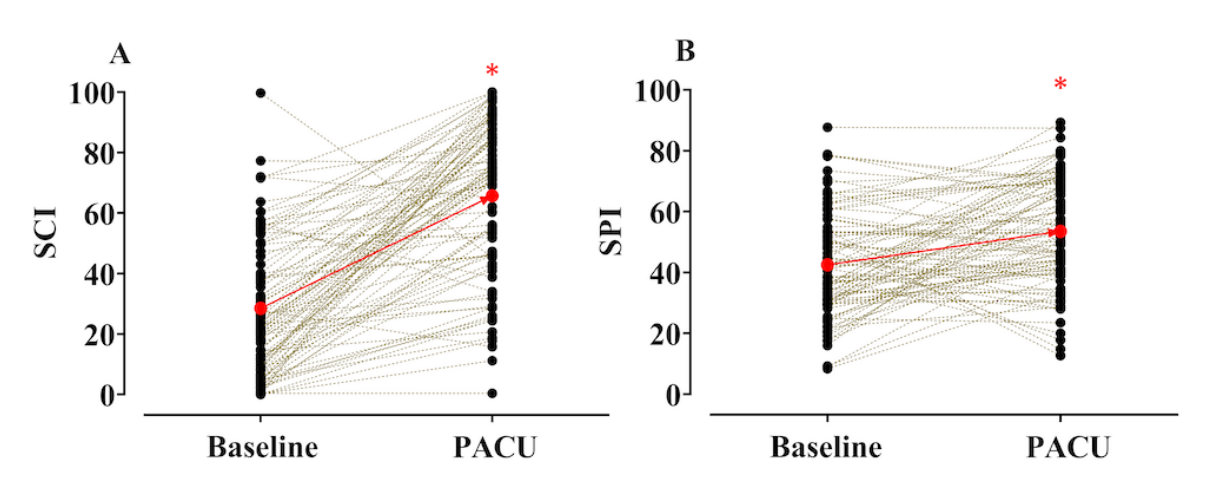
Figure 3. Individual changes (n=100) in the spectrogram-convolutional neural network index (SCI, A) and the Surgical Pleth Index (SPI, B) and without and with pain. * P <.05 vs. baseline. The black circles represent the average of 5 min of the SCI or SPI observed without and with pain. The red circles indicate mean values for all patients. PACU: postanaesthesia care